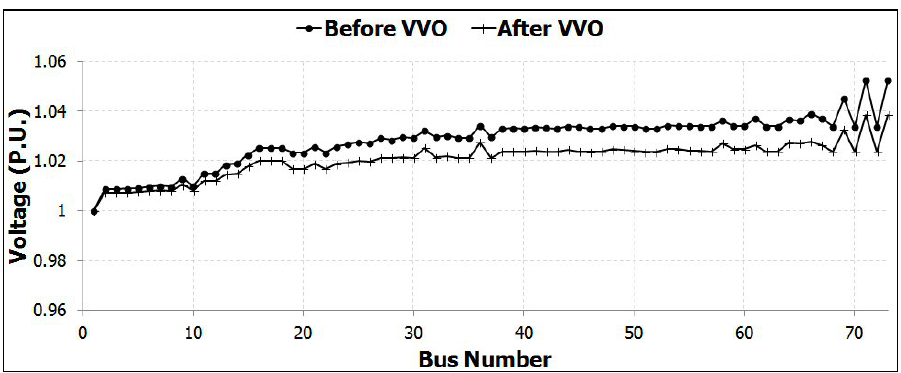
Figure 11. Voltage profile comparison for Case 3.